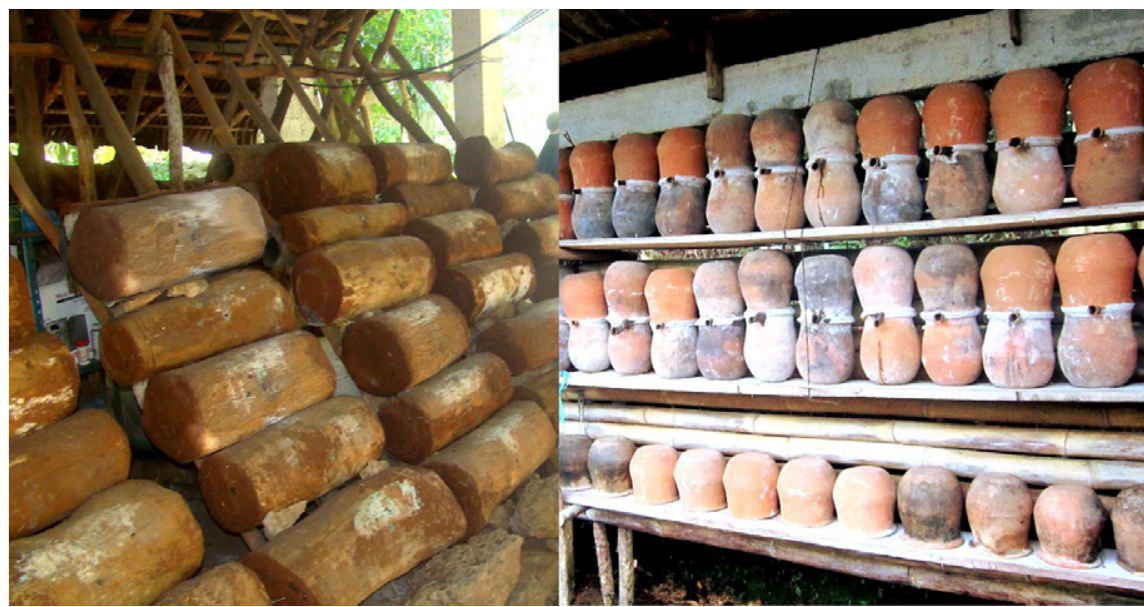
Fig 3 . Indigenous stingless bee husbandry in Mesoamerica involves the use of specially made hives: hollow logs or ‘hobones’ in the Mayan area, and clay pots or ‘mancuernas’, in the highlands of Puebla, Veracruz and Oaxaca (Photos courtesy of Humberto Moo and Margarita